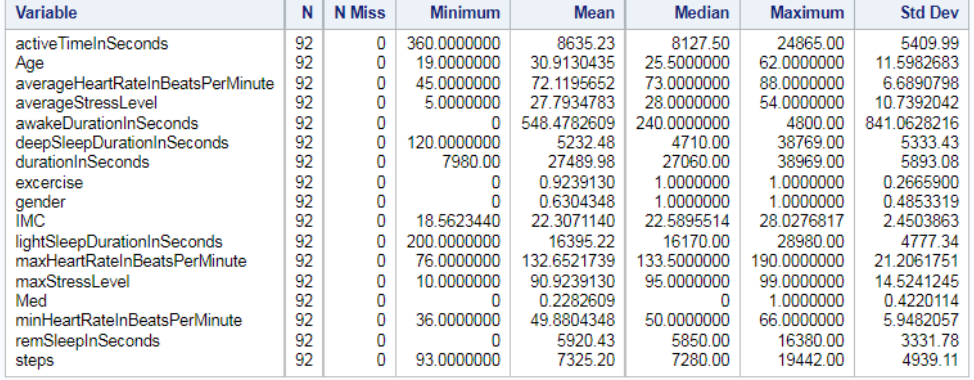
Figure 9. Descriptive Statistics for Numeric